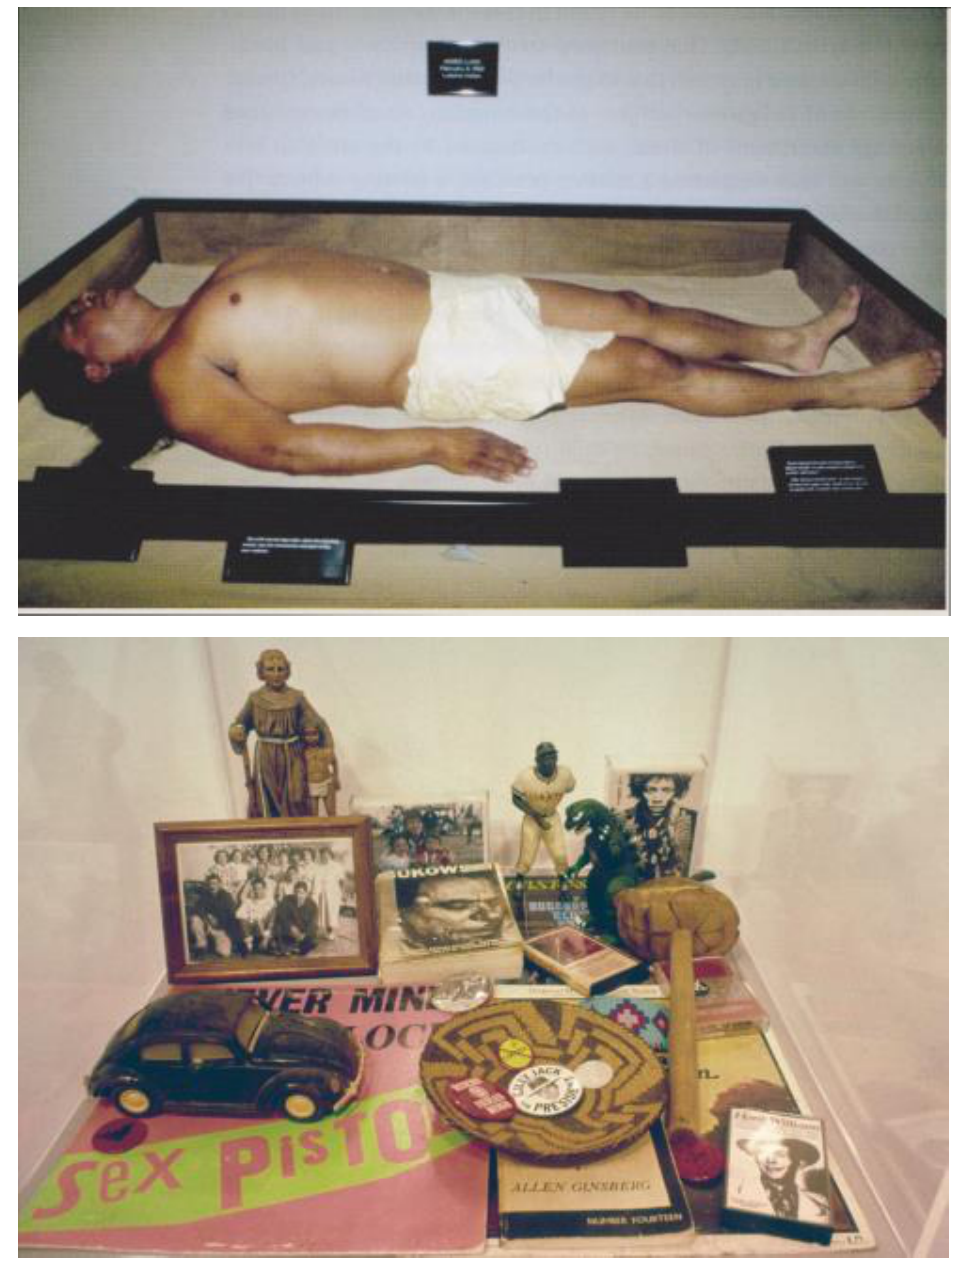
James Luna, The Artifact Piece , installation view, 1987. Live performance-installation, San Diego Museum of Man. Photographer unknown. Copyright 2016 San Diego Museum of Man.